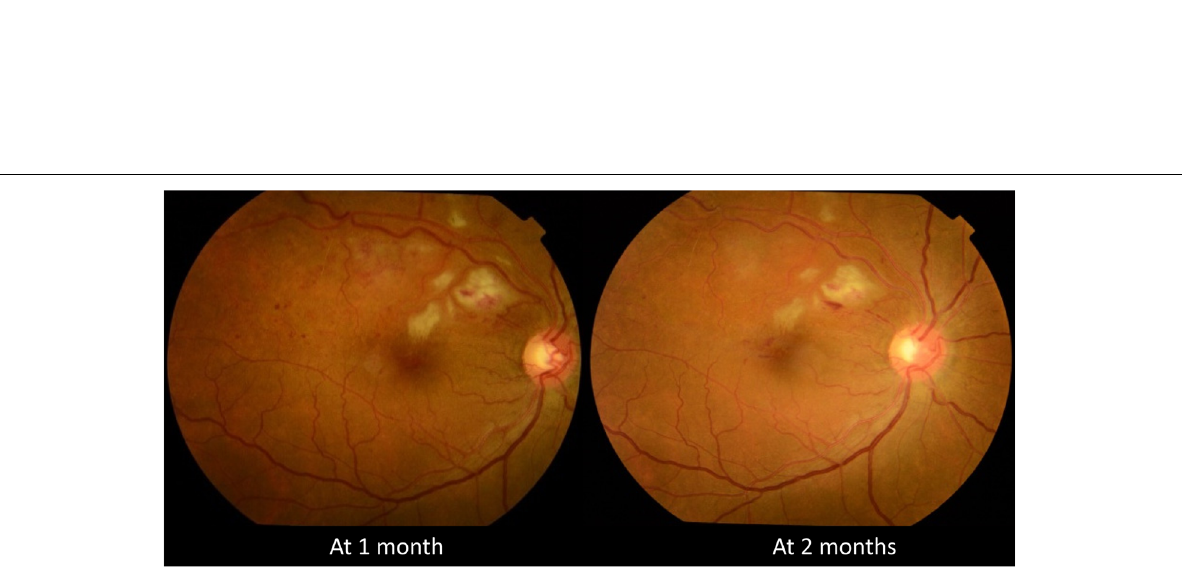
Fig. 3 Fundus photograph of the right eye showing the trend in resolution of retinitis post-treatment